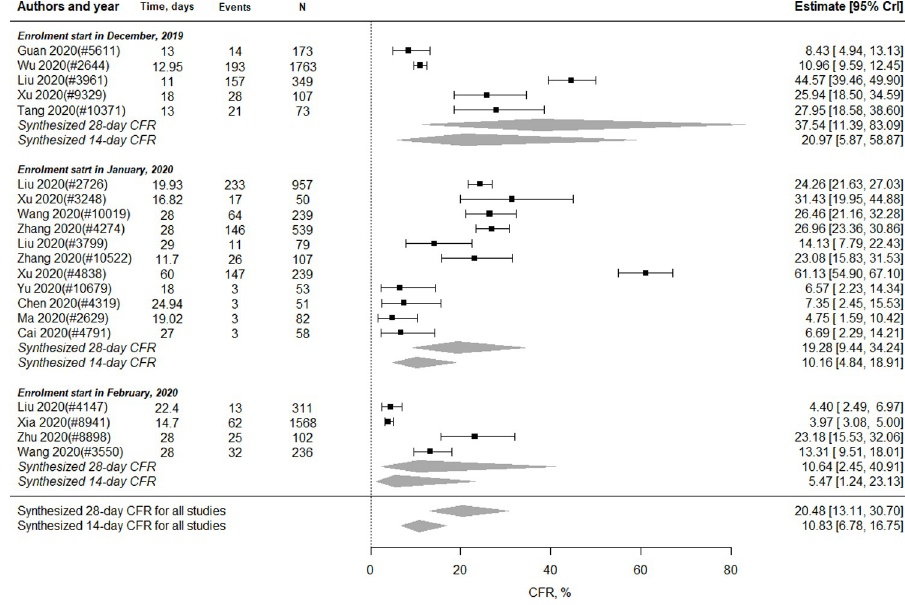
Fig 2. 28-day and 14-day CFRs for severe or critical COVID-19 patients in China.